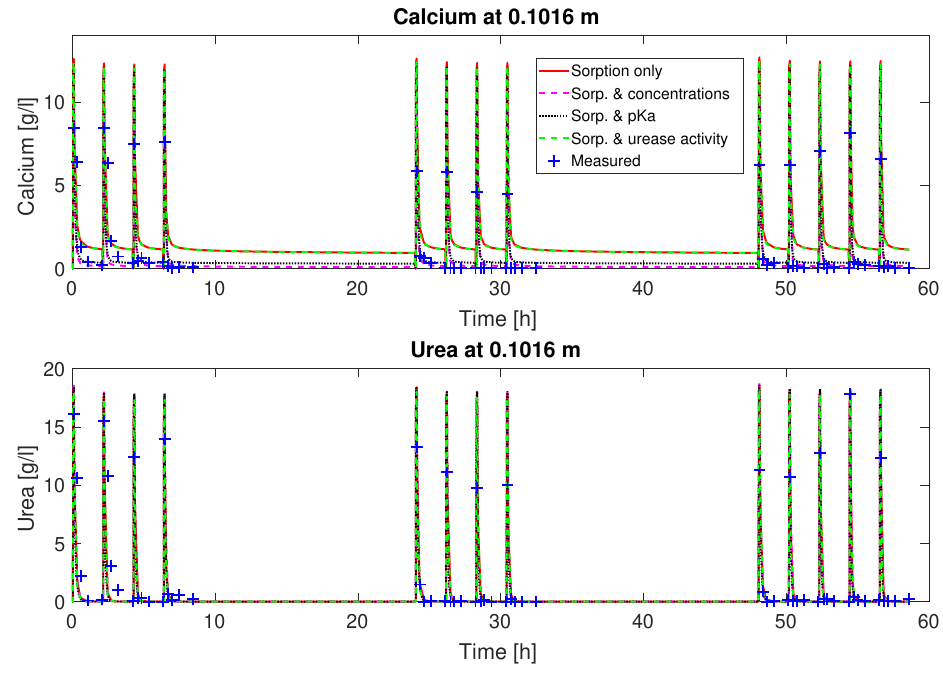
Figure 2. Comparison of the results of the model calibration attempts to the concentration measurements at 10.16 cm from the inlet for column experiment #1 (0.33 M mineralization medium concentration).